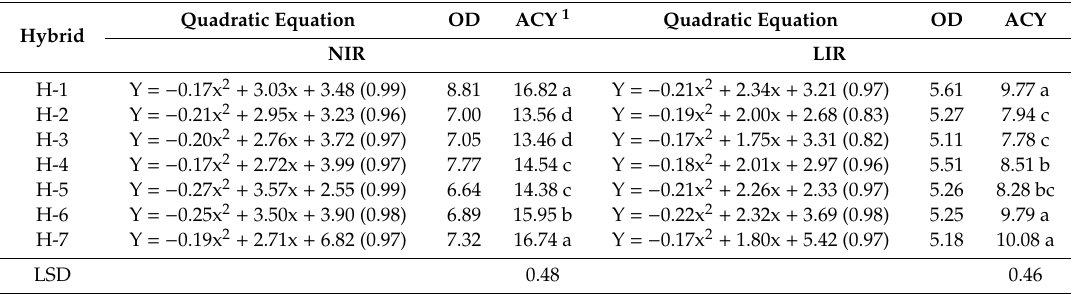
Table 1. The quadratic grain yield response to density (in parenthesis the coefficient of determination, R2), and the respective optimum density (OD, plants/m 2 ) and attainable crop yield (ACY, Mg/ha) of seven hybrids. Data from Mylonas et al. [28] obtained under four densities across five sites at the normal irrigation regime (NIR) and the low irrigation regime (LIR).